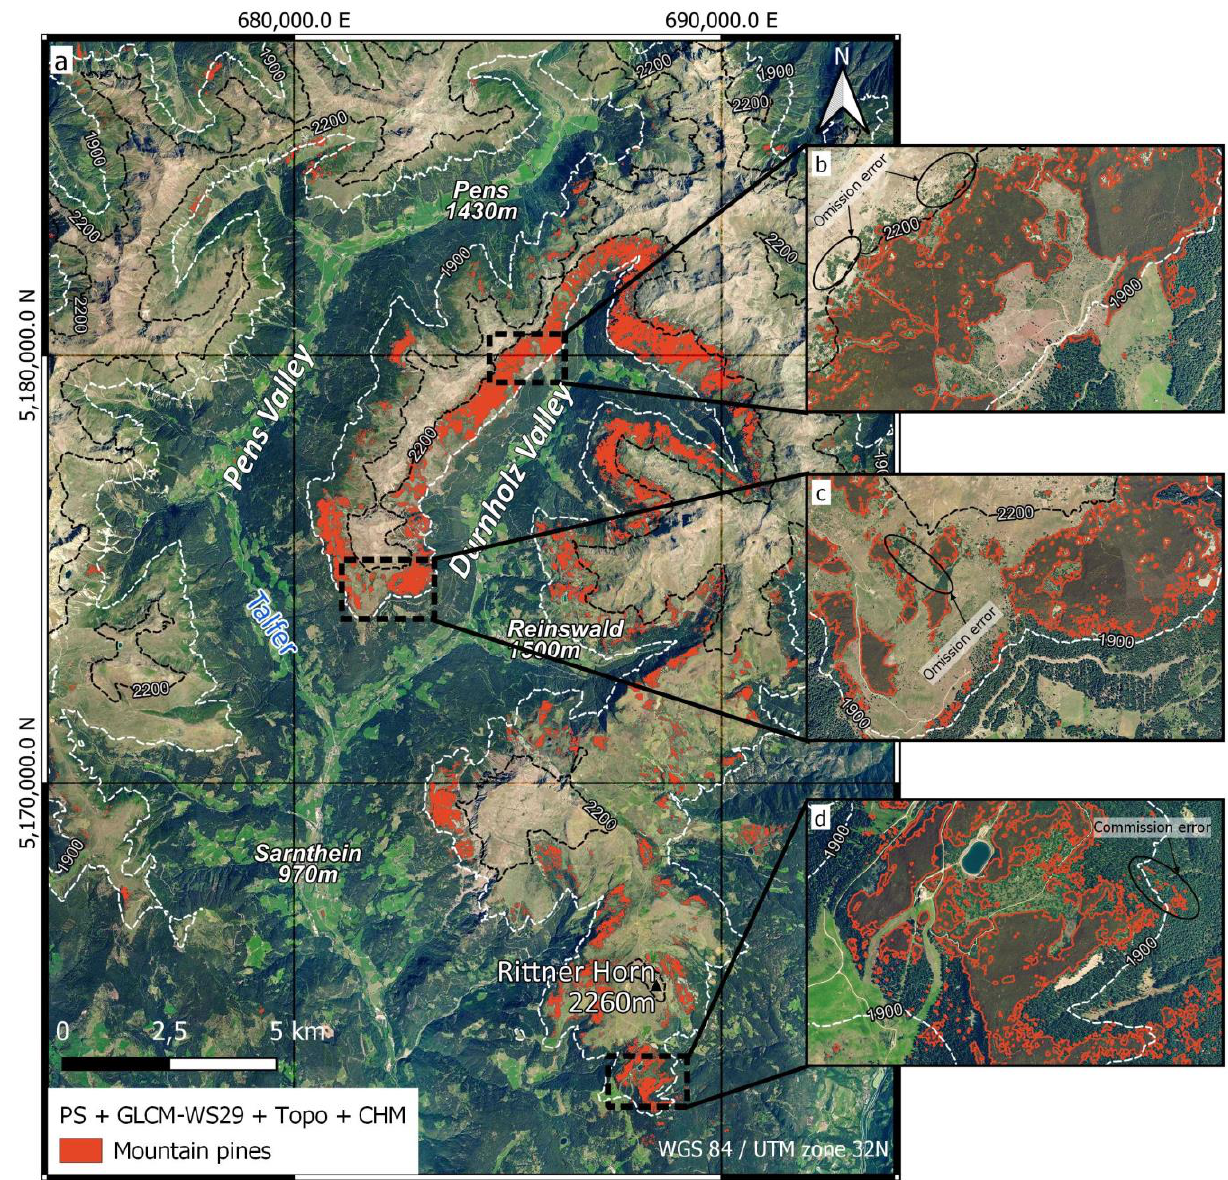
Figure 8. ( a ) Classified mountain pine stands in the Sarntal Alps, South Tyrol. Displayed classification based on PS + GLCM MAX + Topo + CHM feature space (OA 91%). Background: Orthophoto 2020 (Autonomous Province of Bolzano); ( b – d ) Zoom-in examples of classification result with indication of omission and commission errors.